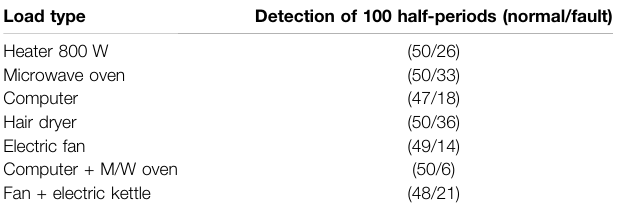
TABLE 3 | Statistics of arc fault detection results ( d 3 ).